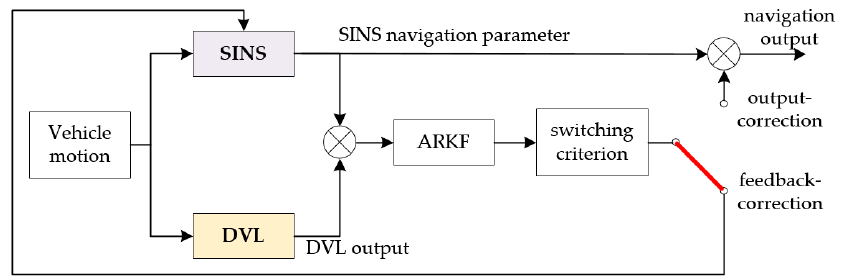
Figure 5. The Adaptive robust Kalman filter (ARKF) based hybrid-correction integrated navigation structure diagram.